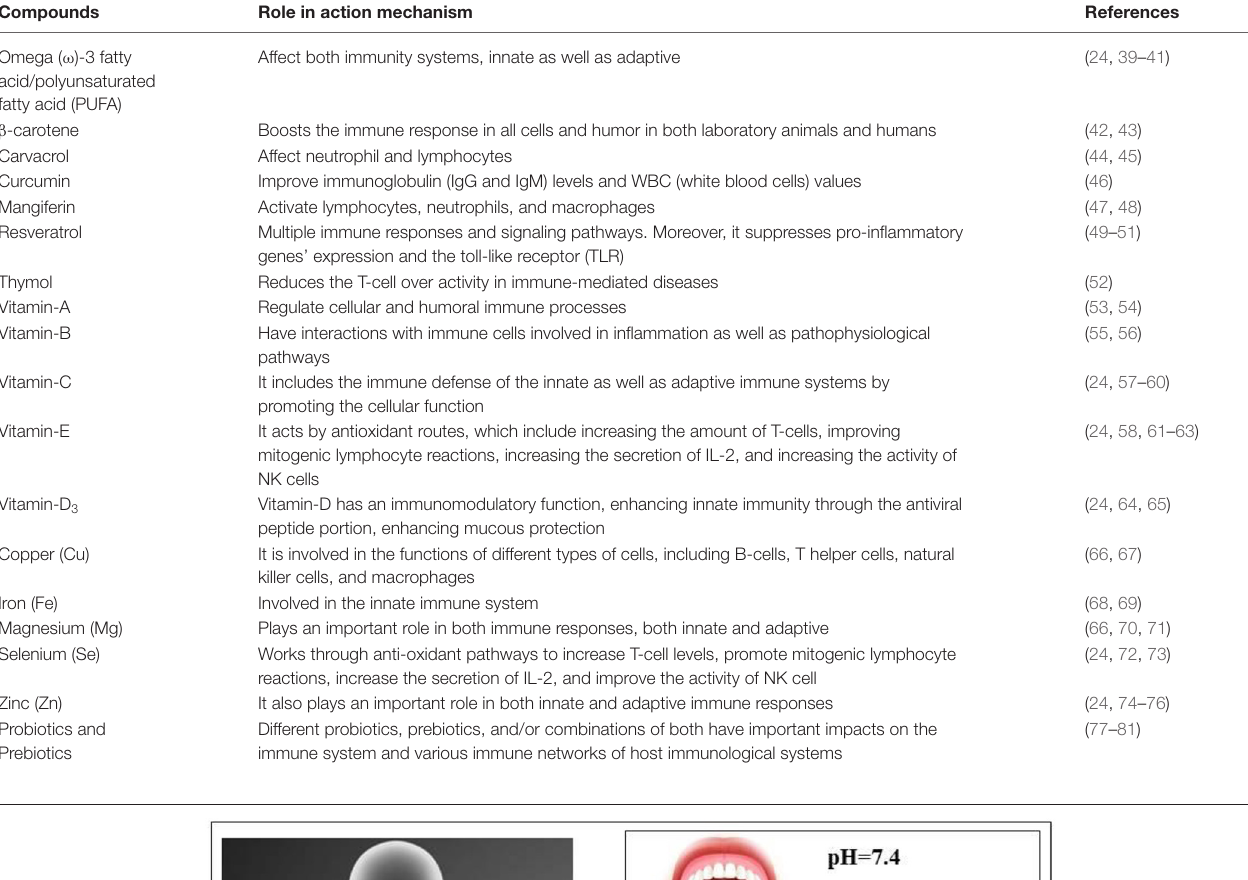
TABLE 1 | Different bioactive compounds (BACs) having immunity-enhancing activity. Compounds